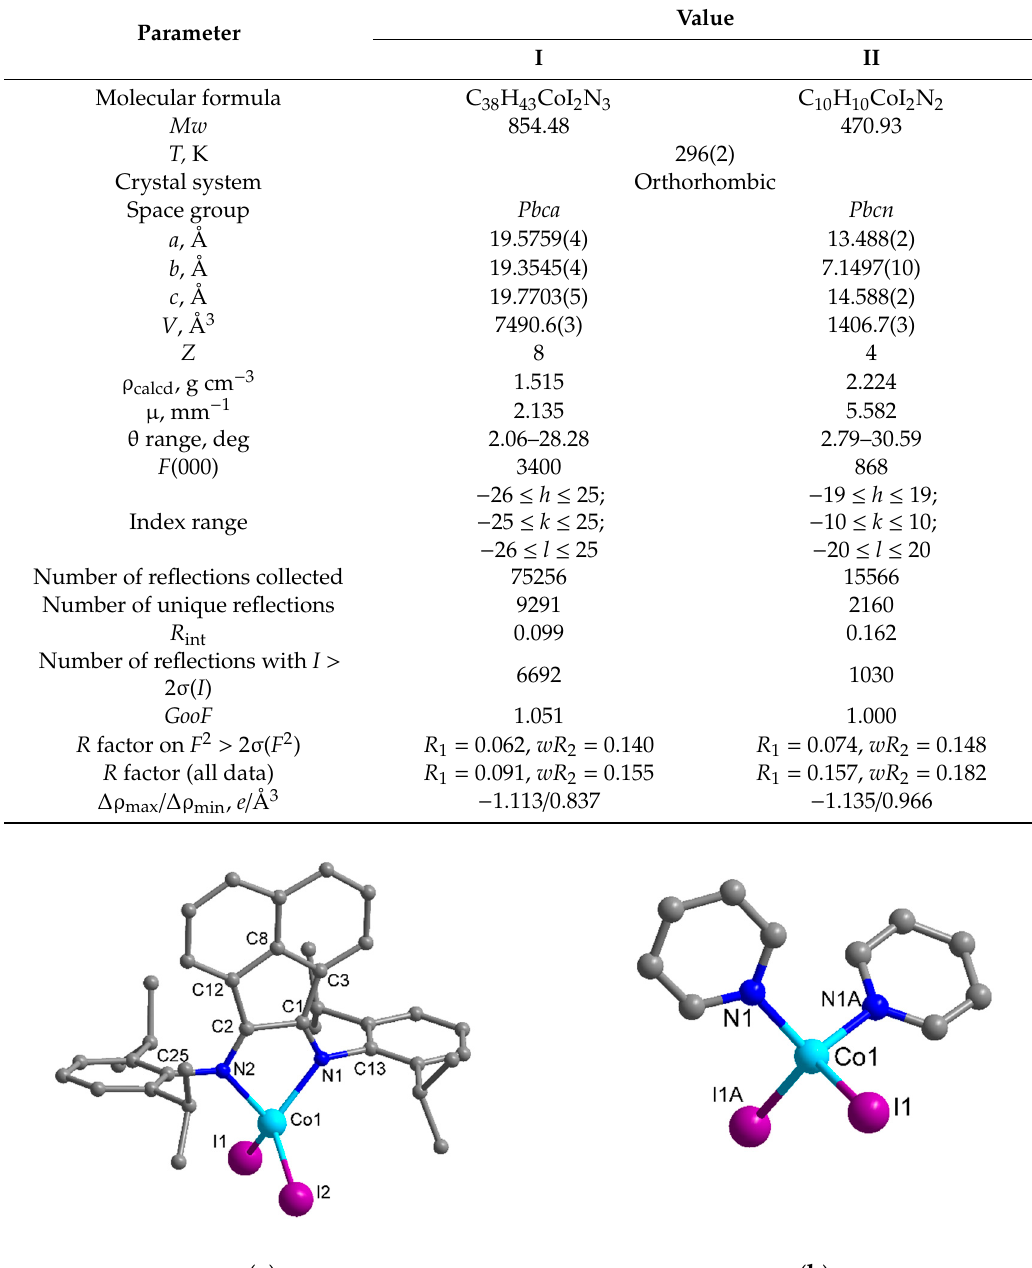
Table 1. Crystallographic data, details of the data collection, and characteristics of the data refinement for I and II.